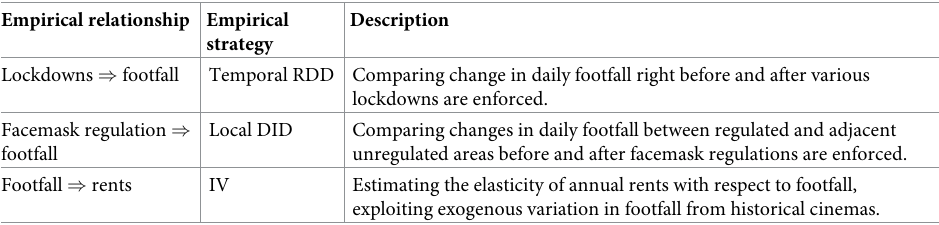
Table 1. An overview of empirical methods